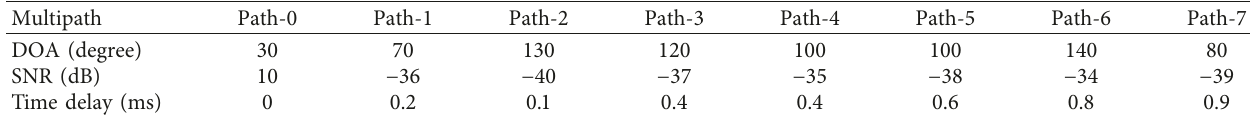
Figure 5: RMSE versus snapshot number. Table 5: Simulated parameters for Examples 4 and